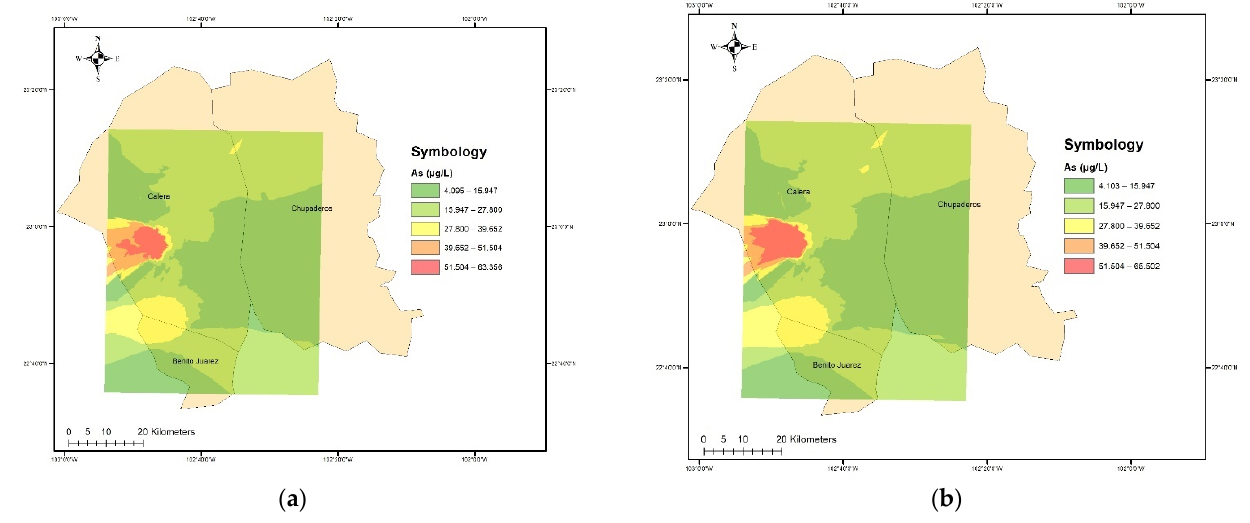
Figure 3. Total arsenic concentration in groundwater of the study area: ( a ) 2015; ( b ) 2020.